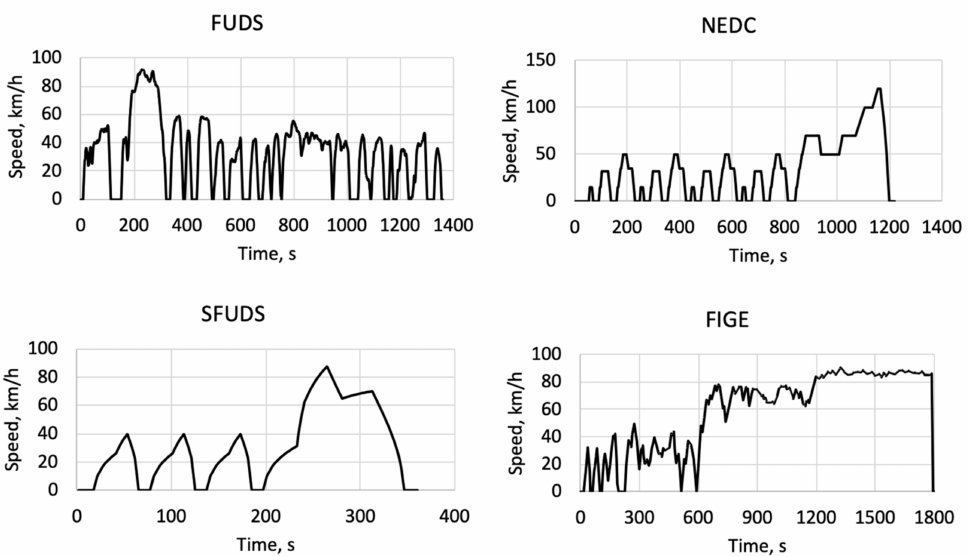
Figure 2. Driving cycles used for model validation.